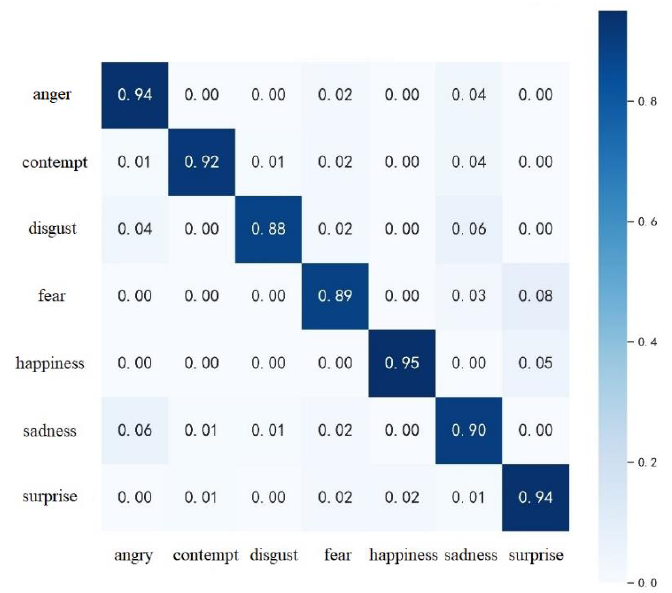
Figure 6. Confusion matrix for CK+ dataset.